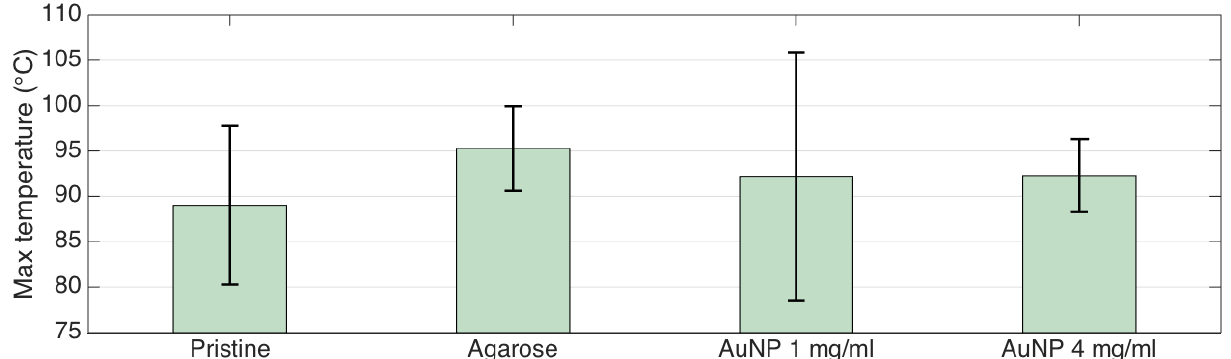
Figure 11. Peak temperature recorded during the RFA experiments under each condition; bars = average of four experiments; error bars = ±standard deviation.